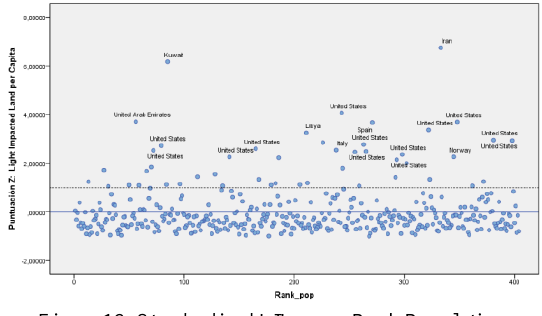
Figure 12. Standardized LILpc vs. Rank Population